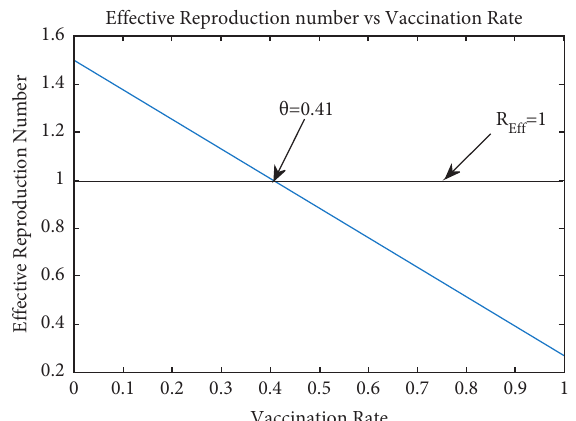
Figure 5: Behavior of effective reproduction number in relation to vaccination rate, θ .